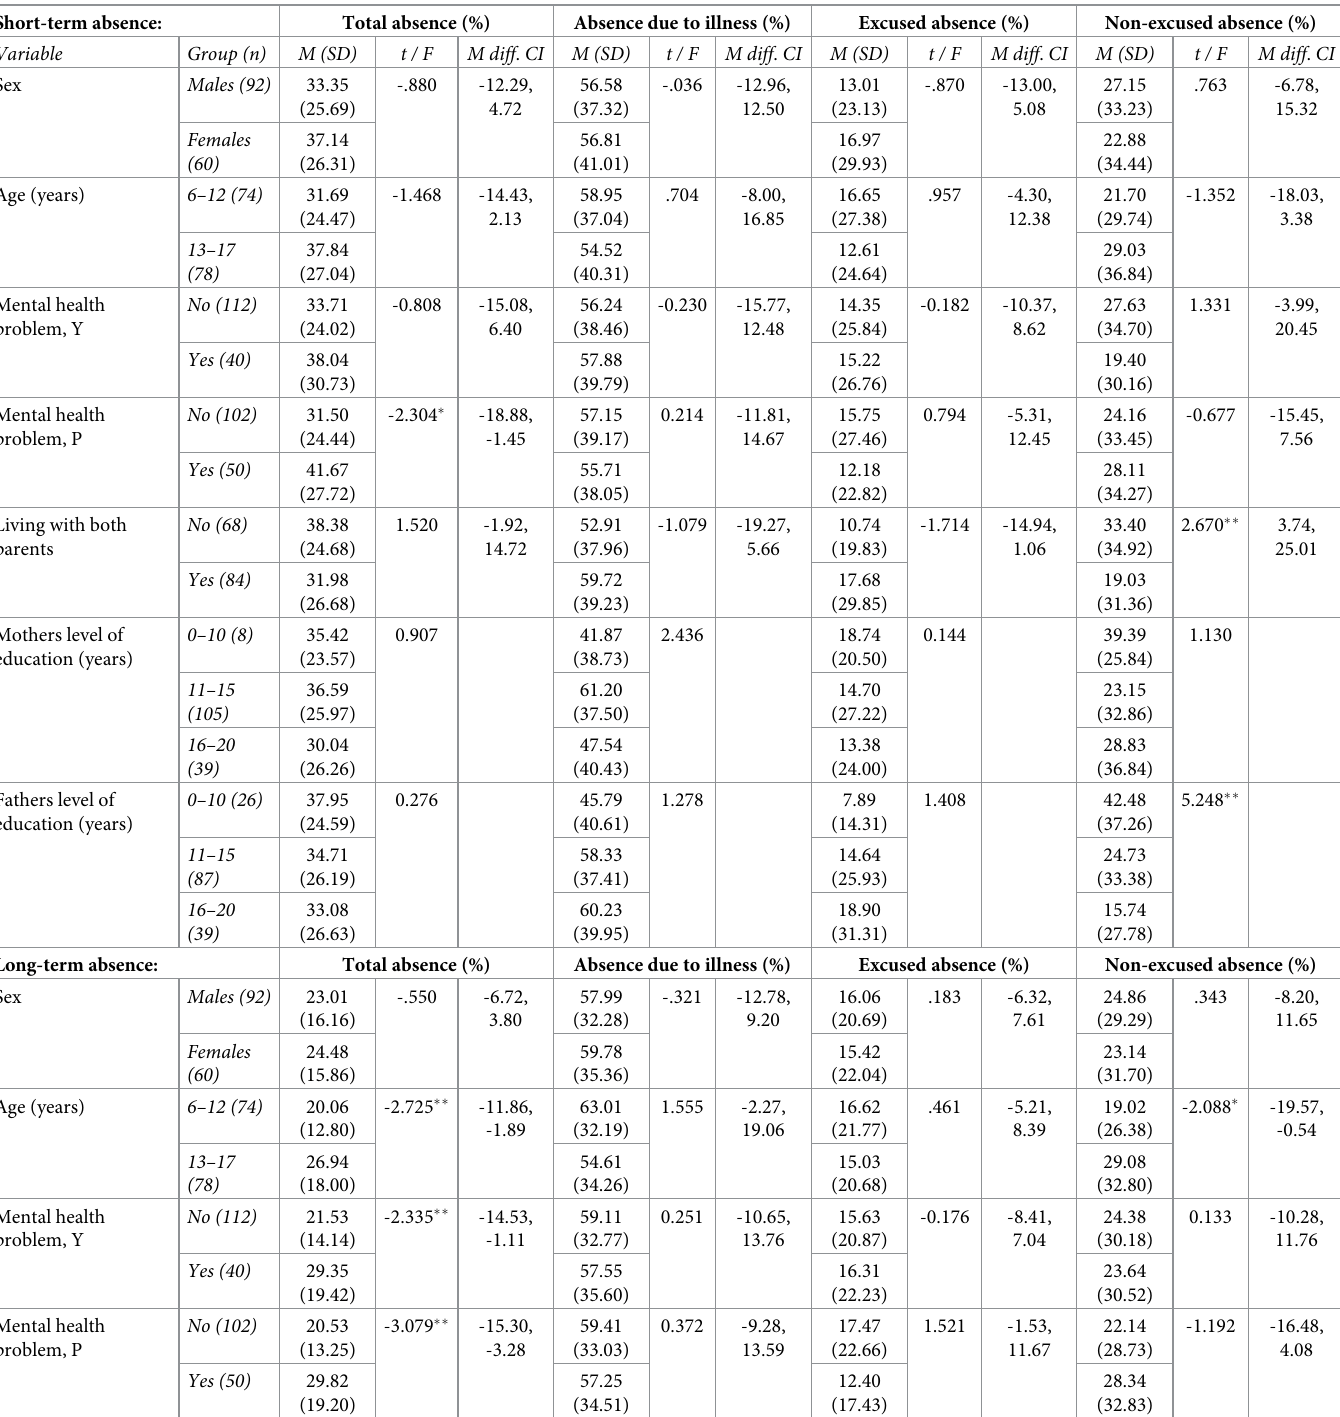
Table 1. Mean comparisons of short- and long-term school absence (%) and related absence categories (%). Short-term